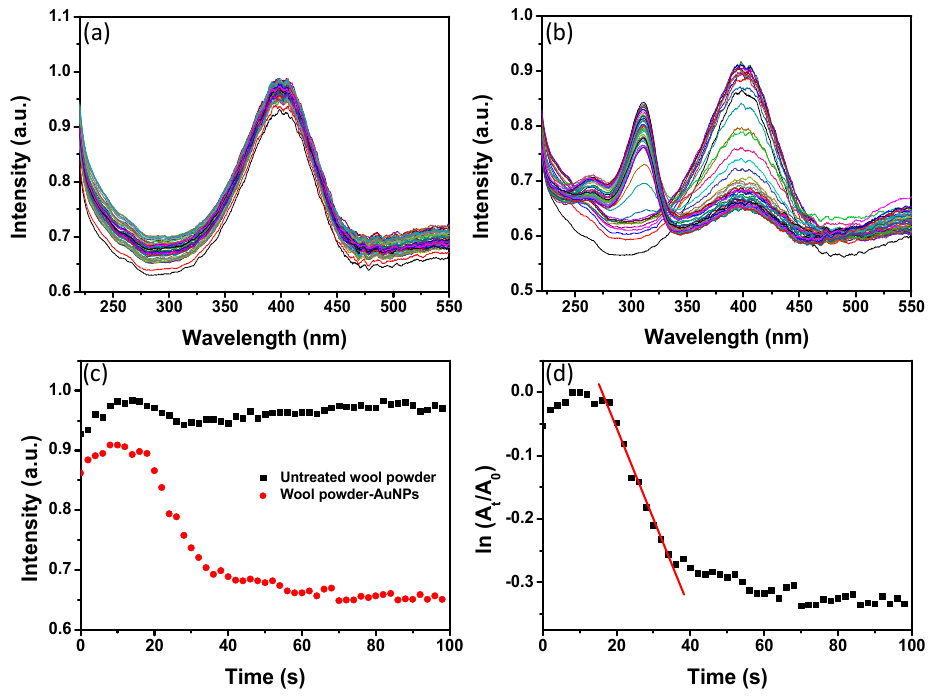
Figure 10. Evolution of UV-VIS absorption spectra of 4-nitrophenol solution with ( a ) untreated wool powder and ( b ) wool powder with AuNPs (from 0.06 mM of Au ions) after NaBH 4 solution was added; ( c ) plots of absorption intensity of 4-NP (400 nm) as a function of reaction time corresponding to untreated and treated wool powders; and ( d ) a plot of ln (A t /A 0 ) of the absorption peak at 400 nm versus time in the presence of AuNP-WP. The time interval between UV-VIS adsorption spectra was 2 s.